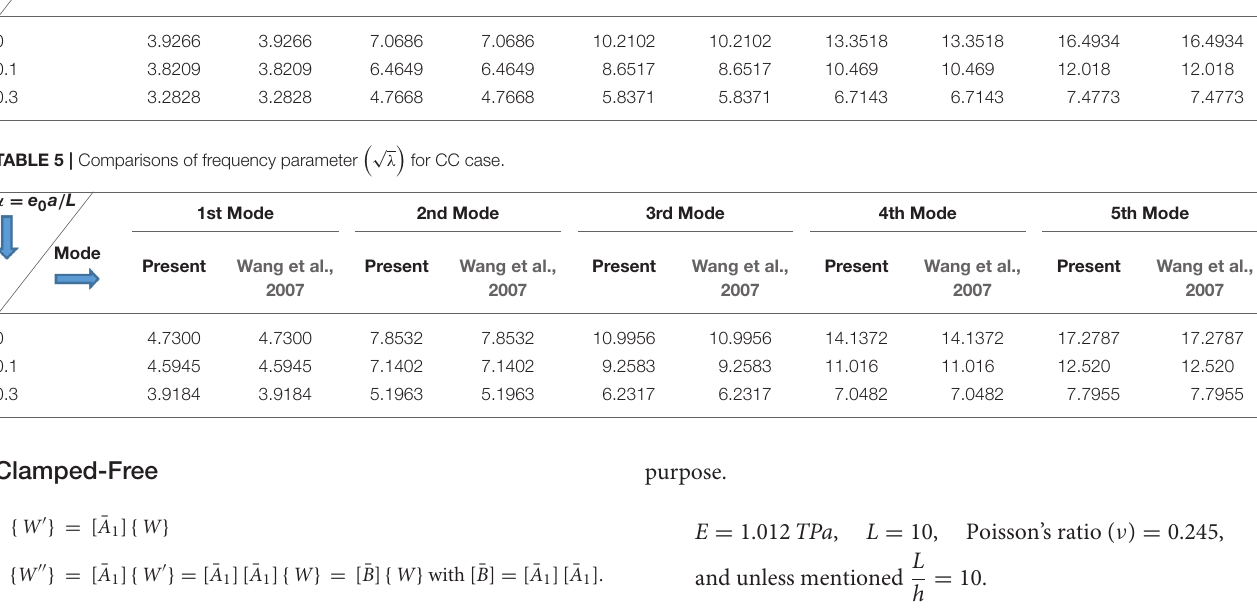
TABLE 4 | Comparisons of frequency parameter α = e 0 a / L